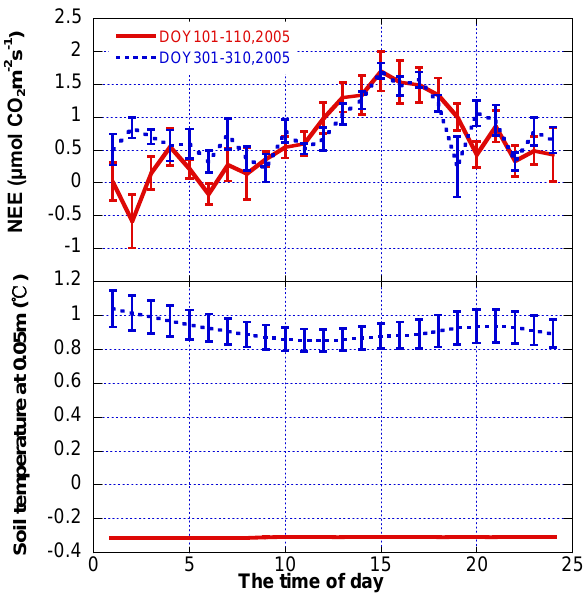
Fig. 8. Examples of 10-day binned diurnal variations in CO 2 flux ( F c ) and soil temperature during non- growth periods. (DOY101–110, and DOY301–310, 2005.) Error bars represent the standard deviation.